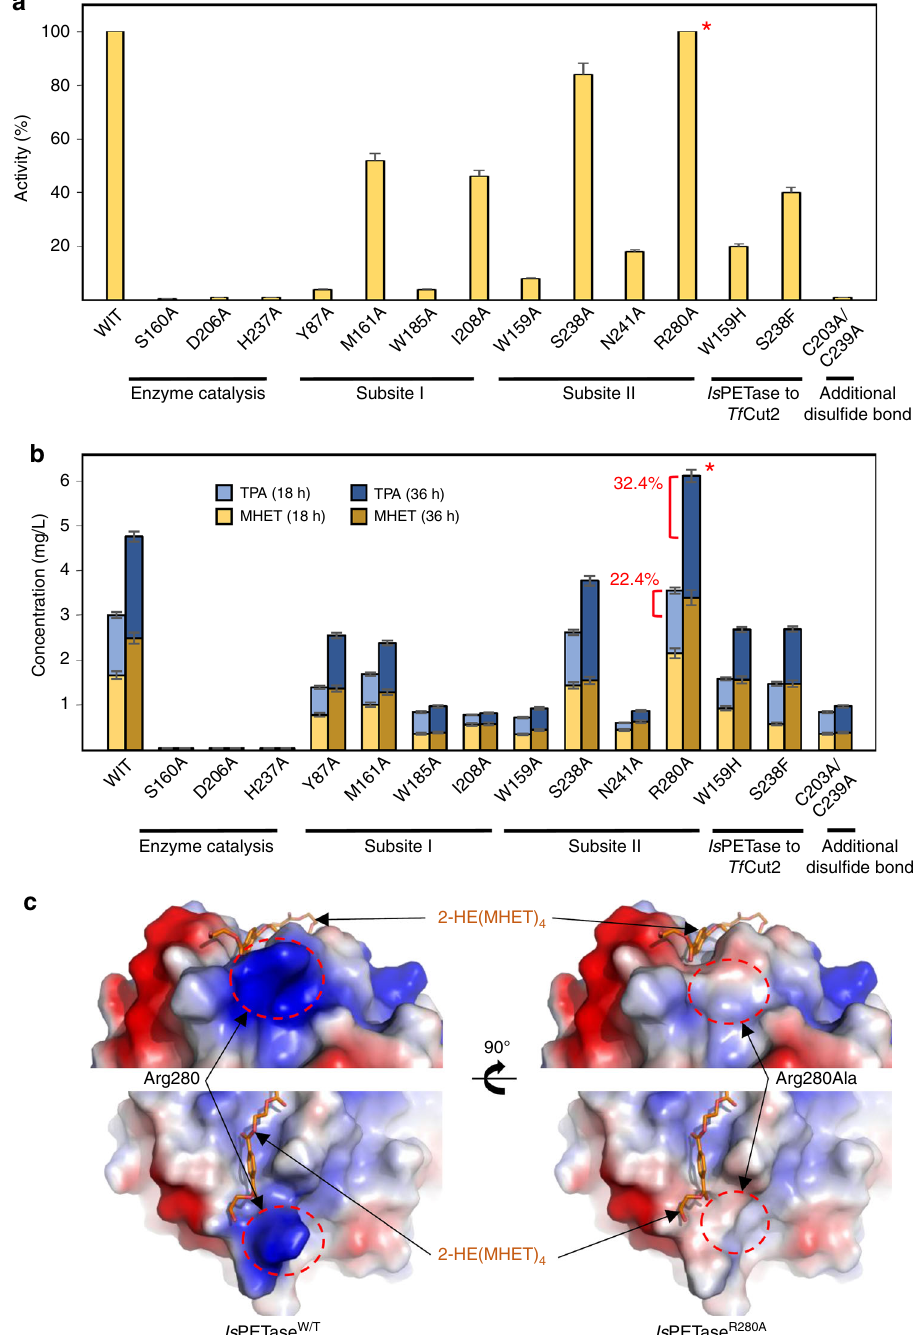
Fig. 3 PETase activity of the variants. a Hydrolytic activities of Is PETase and its variants using BHET as a substrate. PETase activities of Is PETase and its variants were measured using BHET concentration of 200 mg L − 1 and enzyme concentration of 50 nM. The amount of produced MHET was monitored by HPLC analysis. The PETase activities of the Is PETase variants were compared with that of the wild-type. b PETase activity of Is PETase proteins using the PET fi lm as a substrate. PET fi lm degradation activity of Is PETase proteins were measured using enzyme concentration of 200 nM. The amount of produced MHET and TPA was monitored by HPLC analysis. The PETase activities of the Is PETase variants were compared with that of the wild-type. The Is PETase R280A variant showing an increased activity is highlighted with a star mark. c Electrostatic potential surface presentation of Is PETase R280A structure. The 2-HE(MHET) 4 molecule is labeled. The Arg280 residue in Is PETase W/T and the Arg280Ala (R280A) change in Is PETase R280A are indicated with dotted circles. Error bars represent the s.d. values obtained in duplicate